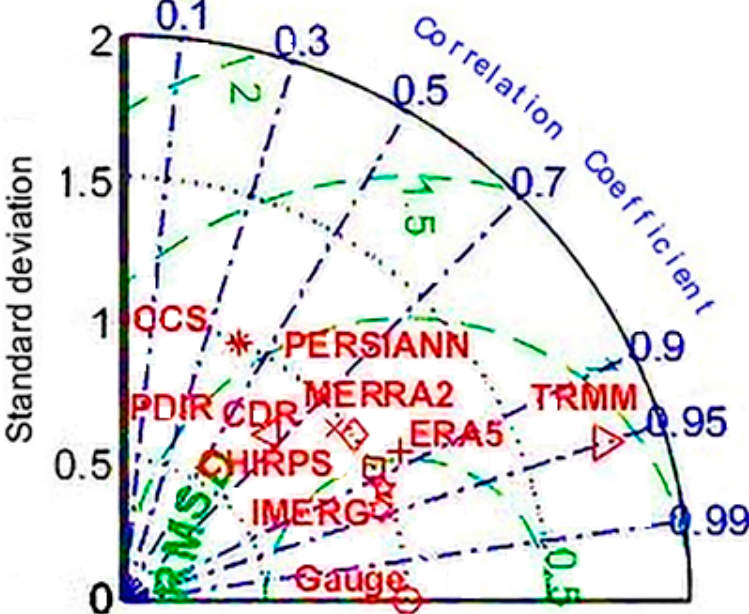
Figure 6. The monthly comparison of all reanalysis and SPPs (CHIRPS, ERA5, IMERG, MEERA2, PDIR, PERSIANN, CCS, CDR, and TRMM) is shown in the Taylor diagram.